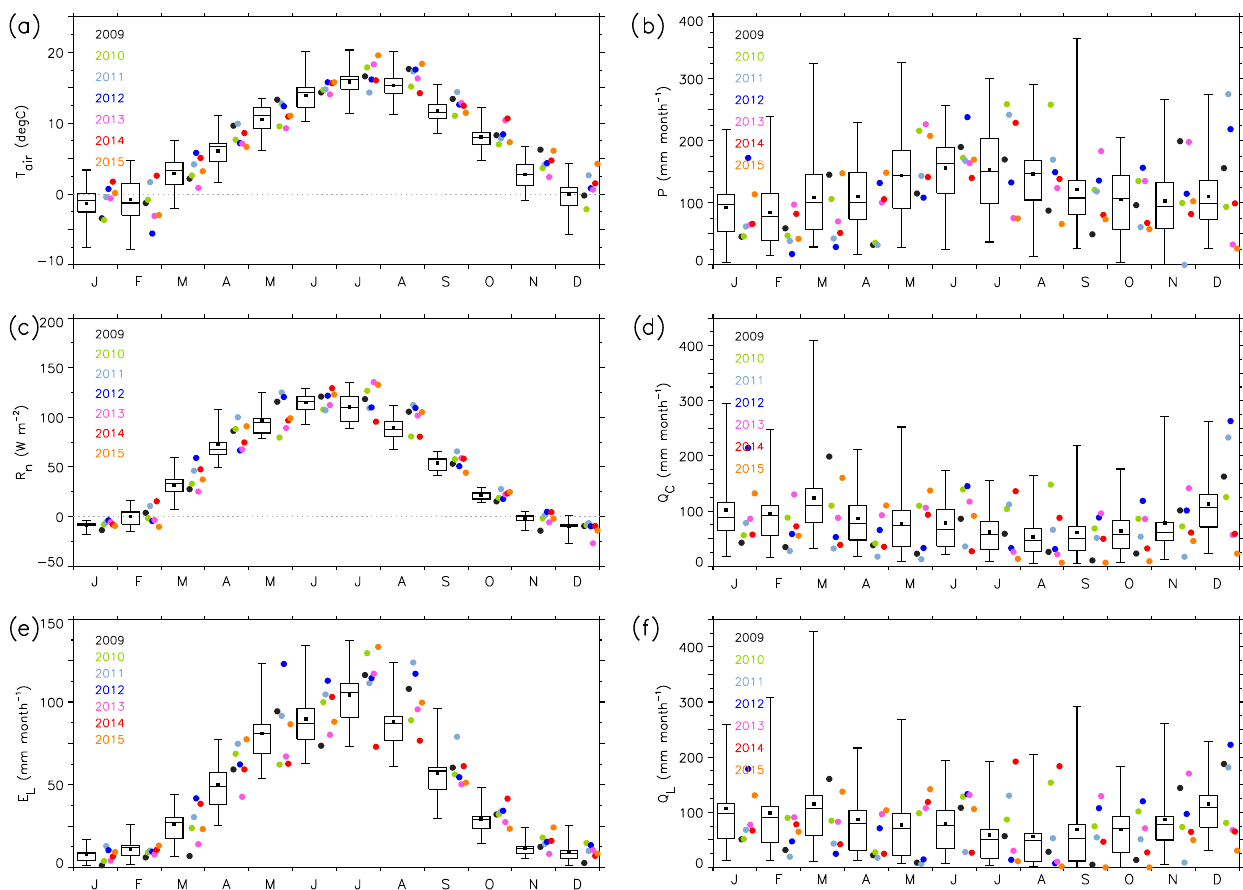
Figure 1. Box plots showing the median, interquartile range as well as minimum and maximum of monthly climatological values (in black, climatological mean included as black square) with the monthly values for the period of investigation 2009–2015 (in color) for (a) air temperature T air , (b) precipitation P , (c) net radiation R n , (d) catchment runoff Q C , (e) lysimeter evapotranspiration E L , and (f) lysimeter seepage Q L .